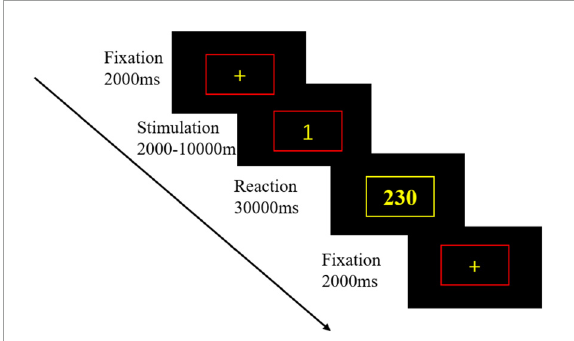
FIGURE1 The psychomotor vigilance task (PVT) paradigm. Firstly, a yellow fixation cross with a red box appeared in the center of a black background on the screen and remained for 2 s. Then, a yellow numerical stimulus was presented in the red box for a random duration of 2–10 s. After that, participant had to respond to the mouse button press as soon as possible. After pressing the button, the box turned yellow, and the number in the box was the participant’s response